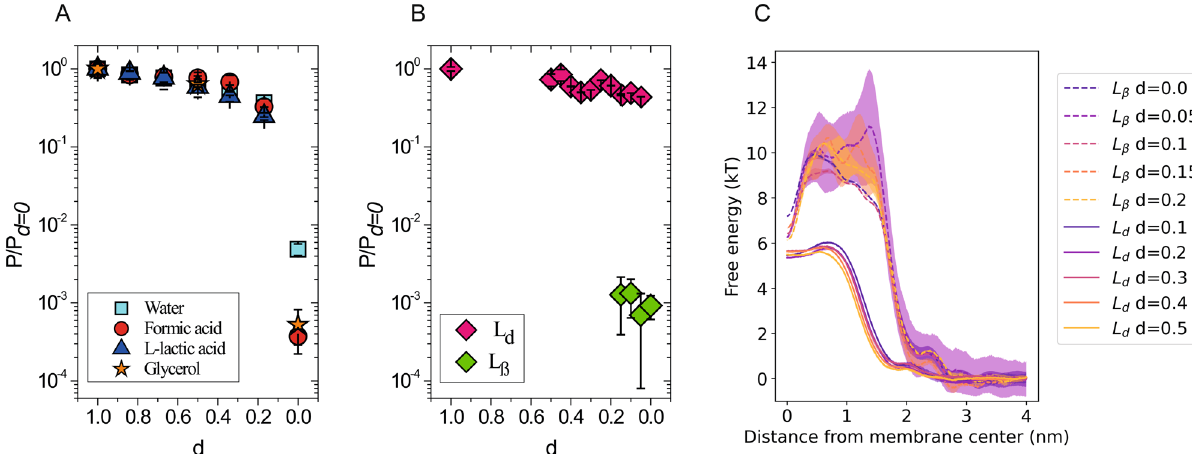
Fig. 3 Permeability of solutes as a function of acyl tail unsaturation. The permeability coef fi cients for each solute are normalized to their respective value at d = 1.0, which in the experimental analysis corresponds to 16.0 (±1.7) × 10 − 3 cm/s, 6.73 (±0.74) × 10 − 3 cm/s, 0.198 (±0.033) × 10 − 3 cm/s, and 2.3 (±0.2) × 10 − 6 cm/s for water, formic acid, L-lactic acid, and glycerol, respectively. Permeability coef fi cients at 20 °C for water, formic acid, L-lactic acid, glycerol from experiments ( A ) and permeability coef fi cients for the solute of the hydrophobic level I from MD simulations ( B ) for membranes in the L d and L β phase. Simulations in the range of d between 0.17 and 0.05 show results from both membrane phases, L d and L β , which were used as a starting con fi guration and remained meta-stable within the simulation time. Data are presented as mean values ± SEM. Data are presented as mean values ± SEM. Error estimates represented by error bars around the mean values are described in “ Methods ” ( “ Fit of the in vitro kinetics ” for experimental data, “ Inhomogeneous solubility-diffusion model ” , for MD simulations). The numerical values are presented in Supplementary Table 3. C Free energy pro fi les from simulated membranes at L d phase (solid lines) and L β phase (dashed) with varying degree of unsaturation d